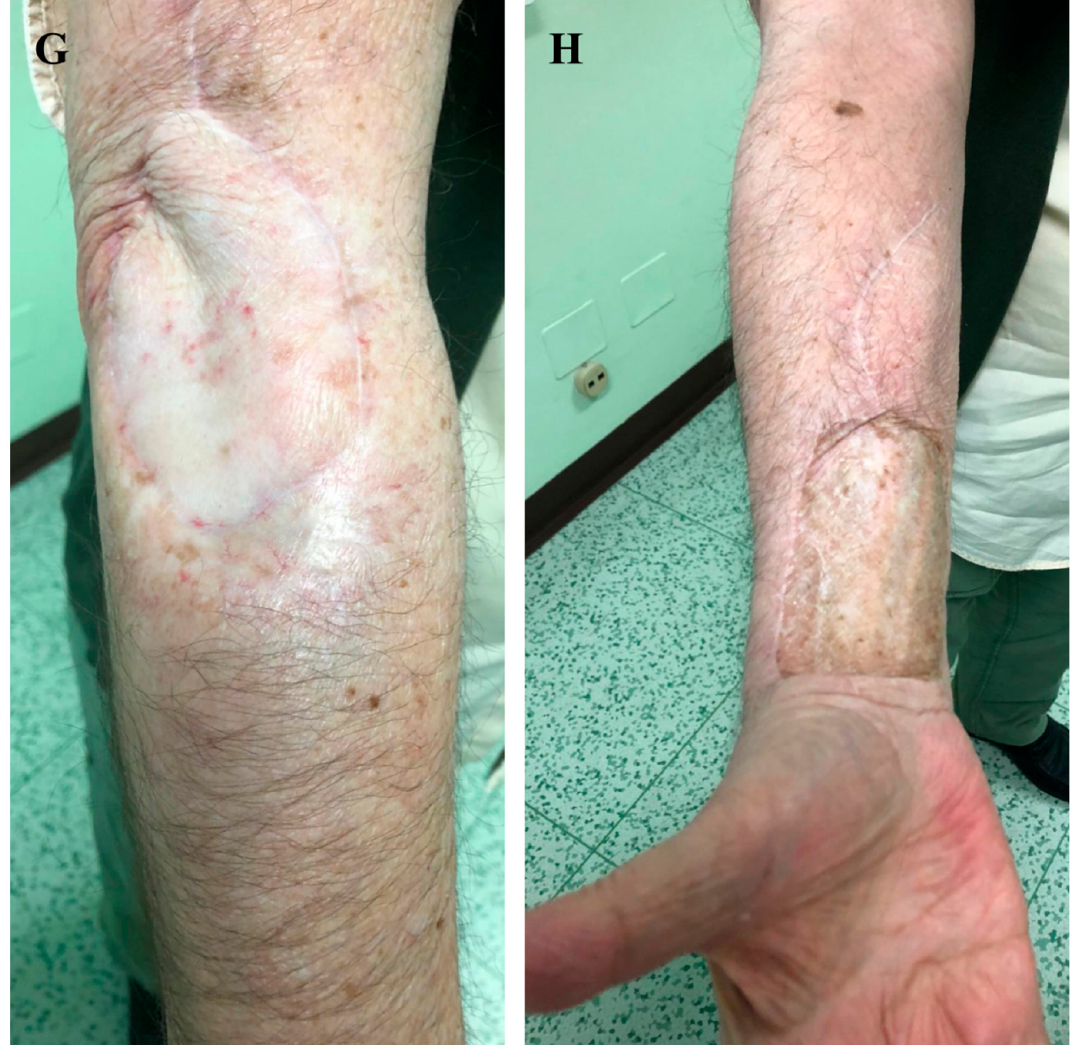
Figure 3. Synovial sarcoma resection after radiotherapy, treated with one-stage reconstruction. ( A ) Preoperative magnetic resonance imaging (MRI) of the affected elbow. When a pedicled or free perforator flap was required, the vascular network was studied with particular attention. ( B ) Clinical aspect of the skin with the soft tissue mass. ( C ) Surgical field after tumor excision showing extensive soft tissue loss, ( D ) corresponding to the specimen. ( E ) The flap was harvested in the forearm and ( F ) passed under a cutaneous bridge to reach the residual defect. ( G , H ) Clinical results at three years of follow-up.